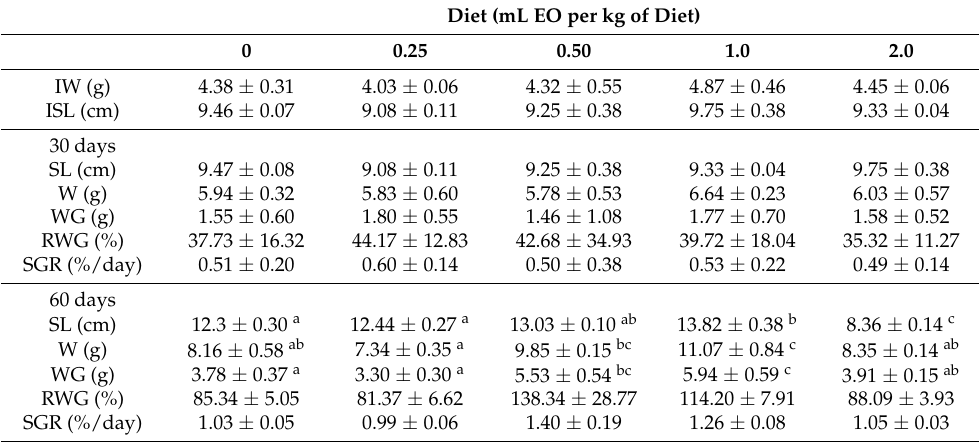
Table 4. Growth performance of silver catfish ( Rhamdia quelen ) fed with diets containing different concentrations of Cinnamomum cassia essential oil (CCEO).